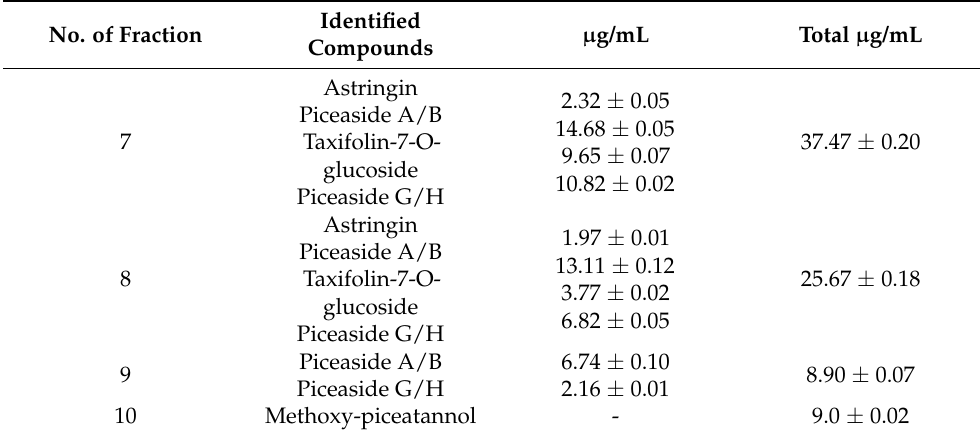
Table 5. Amounts of phenolic compounds in the main fractions obtained from methanolic